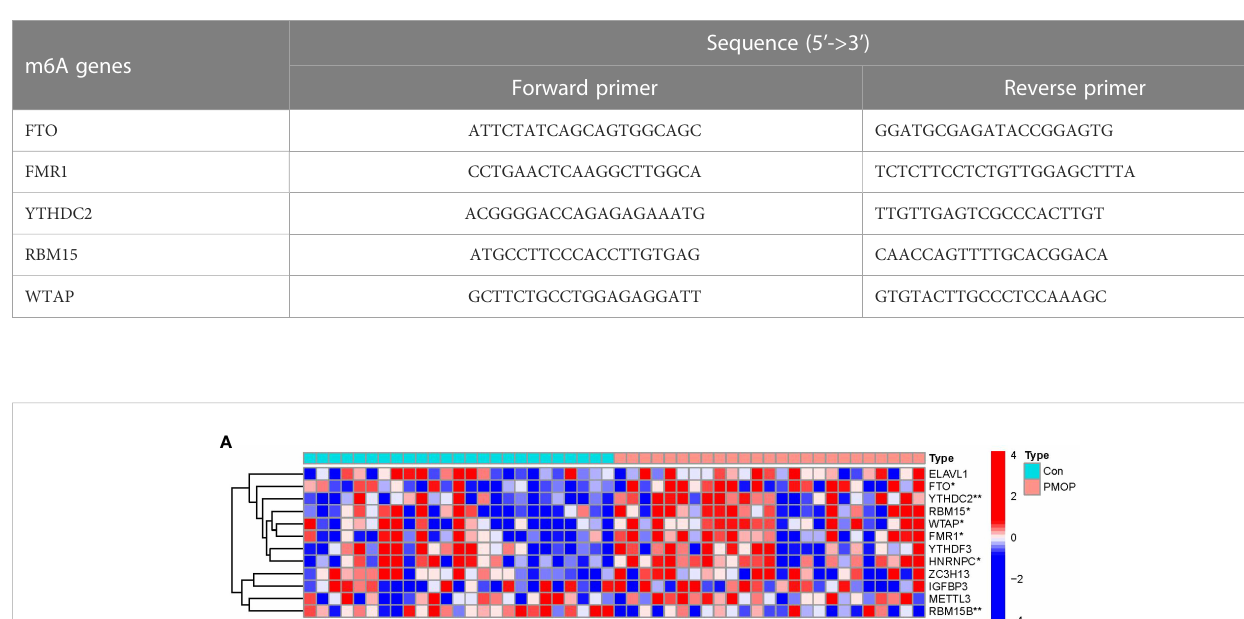
TABLE 2 Sequences of m6A gene-speci fi c primers used for RT-qPCR.